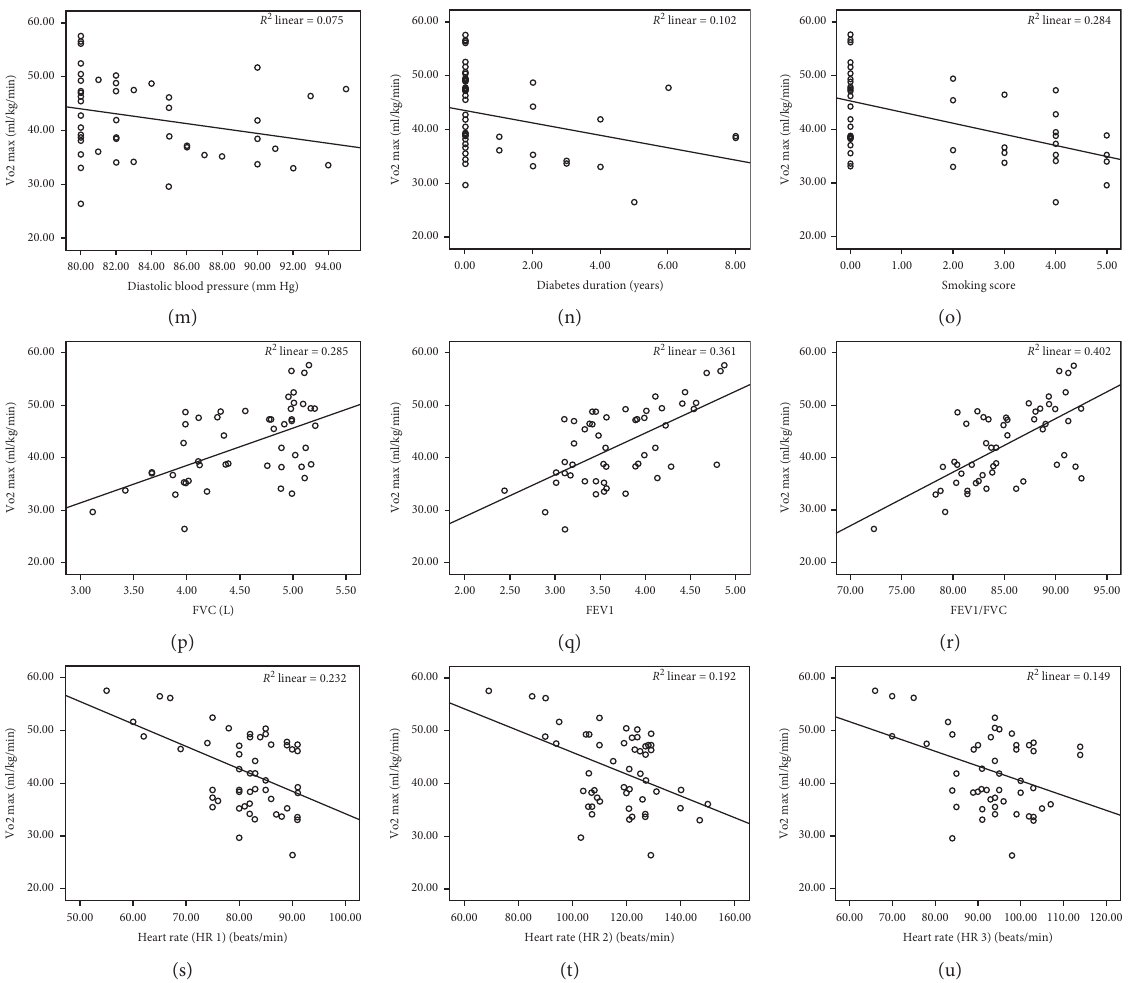
Figure 2: The relationship between the estimated VO 2max and (a) age, (b) weight, (c) height, (d) body mass index, (e) waist circumference, (f) the sum of skinfold, (g) fat percentage, (h) thigh length, (i) lower-limb length, (j) thigh circumference, (k) physical activity, and (l) systolic blood pressure. The relationship between the estimated VO 2max and (m) diastolic blood pressure, (n) diabetes duration, (o) smoking, (p) forced vital capacity, (q) forced expiratory volume in the first second, (r) ( FEV1/FVC ) , (s) pre-exercise heart rate (HR 1), (t) postexercise heart rate (HR 2), and (u) postexercise heat rate (HR